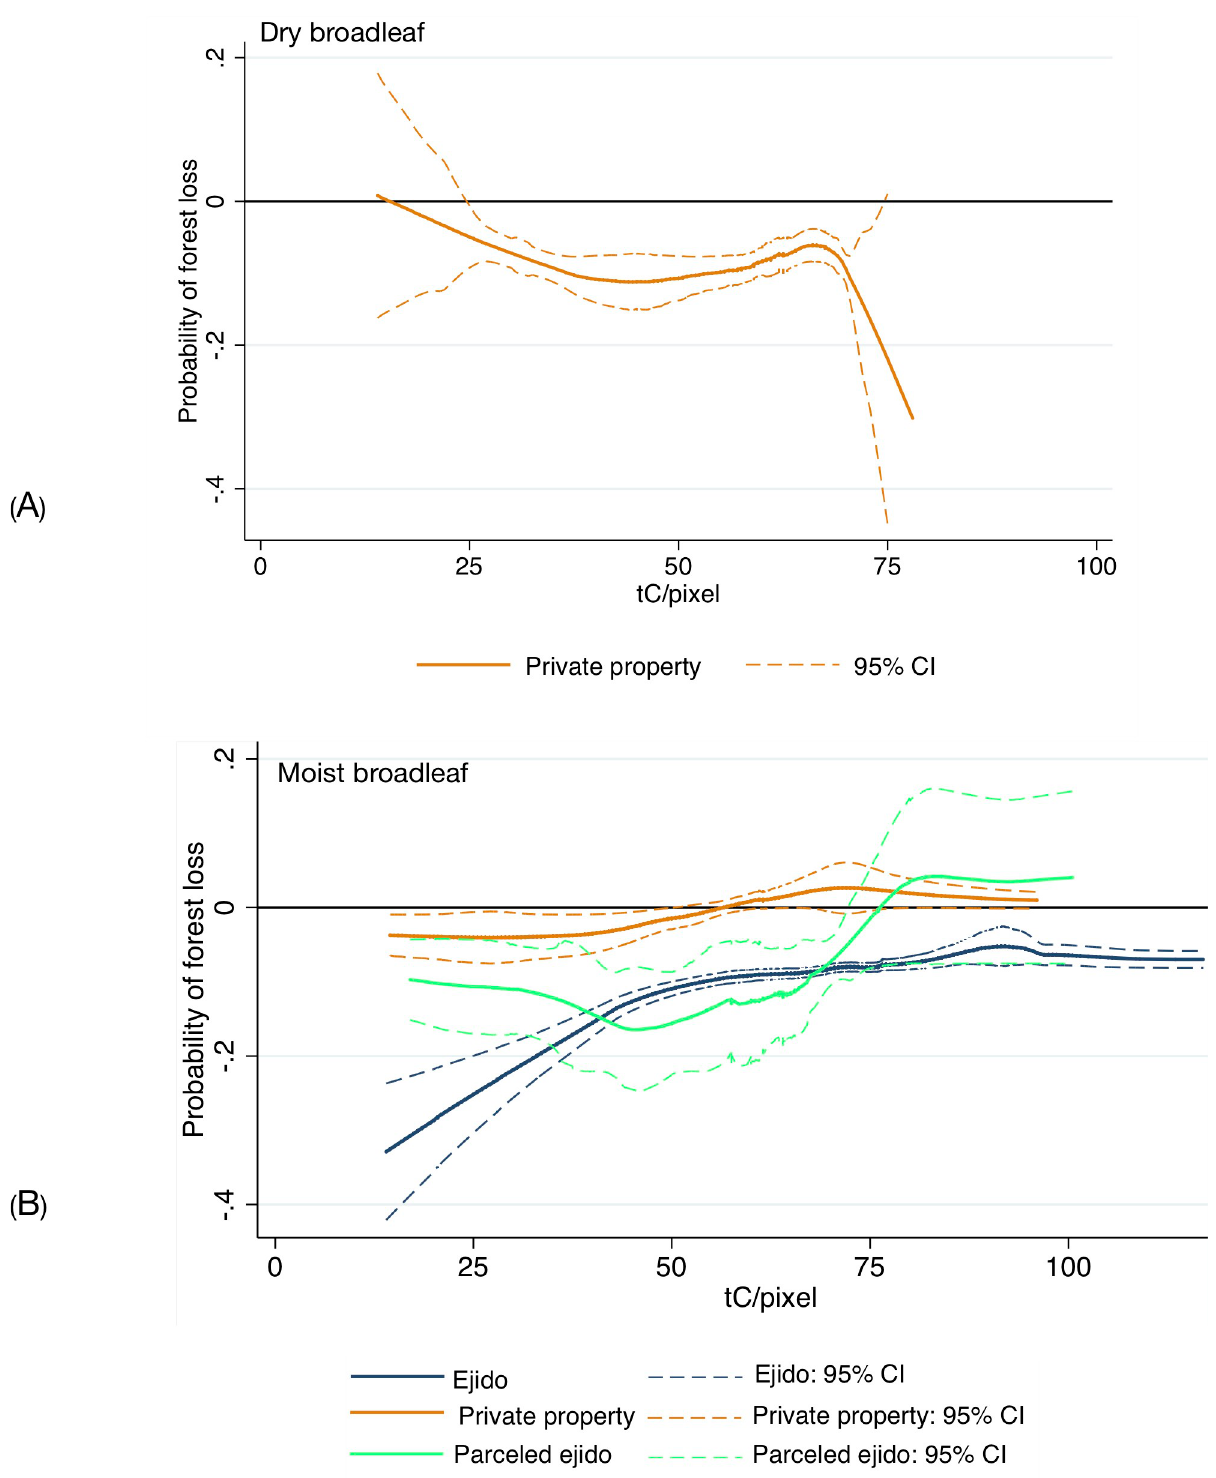
Fig 4. Results from the post-matching partial linear models comparing observationally similar protected and unprotected pixels under the 3 tenure regimes for (A) dry broadleaf forests (B) moist broadleaf forests. The negative values indicate that formal protection was effective in reducing forest loss relative to observationally similar pixel under the same tenure regime; the estimate is statistically significant if the confidence intervals do not span the 0 horizontal line. Because we could not find a viable specification for the ejidos and parceled ejidos in dry broadleaf forests, we do not provide estimates for those